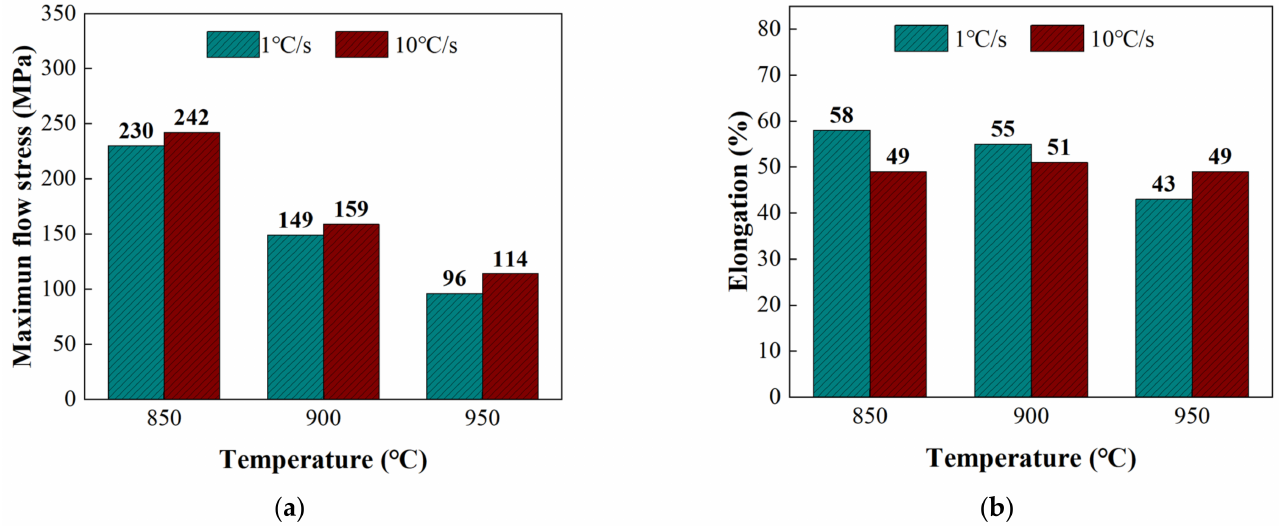
Figure 6. Effects of forming temperature and heating rate on ( a ) the maximum flow stress and ( b )